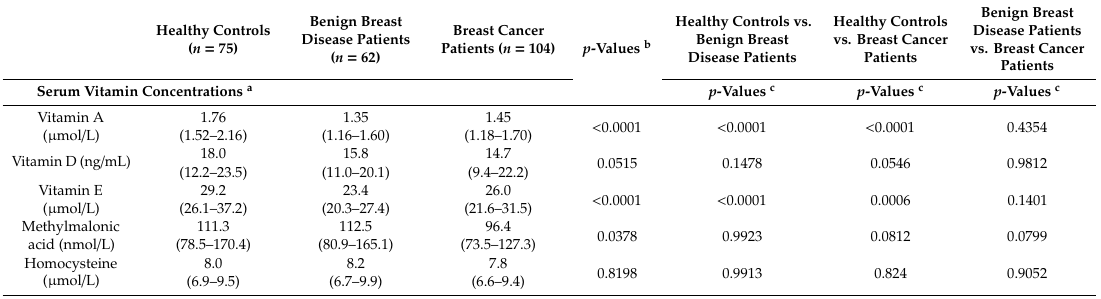
Table 2. Serum concentrations of vitamins and vitamin B12 indicators in the study